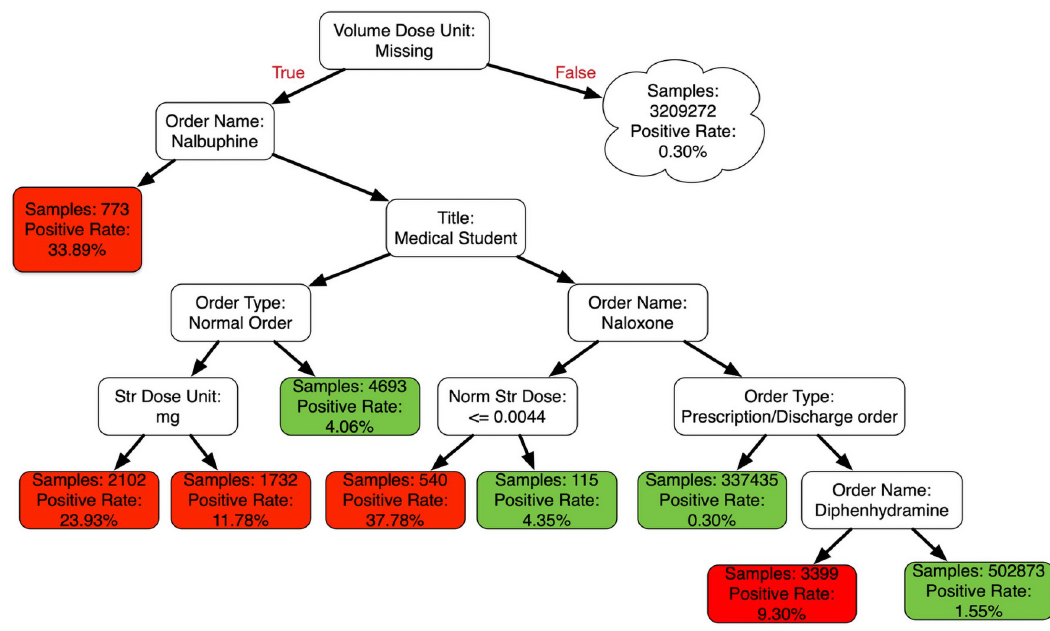
Fig 2. Example partial tree from the DT model showing the causal patterns for medication errors. In this tree, if the decision is false (i.e., not a voided order), take the right branch; similarly, if the decision is true (i.e., voided order), take the left branch. Red and green boxes highlight the positive rates of greater than and less than 5% respectively. Note that this is a small portion of the total tree.